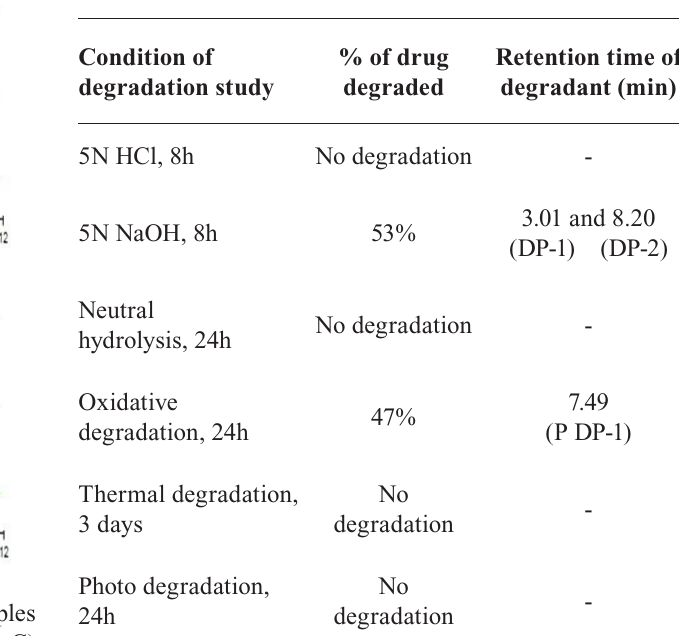
TABLE II - Summary of degradation